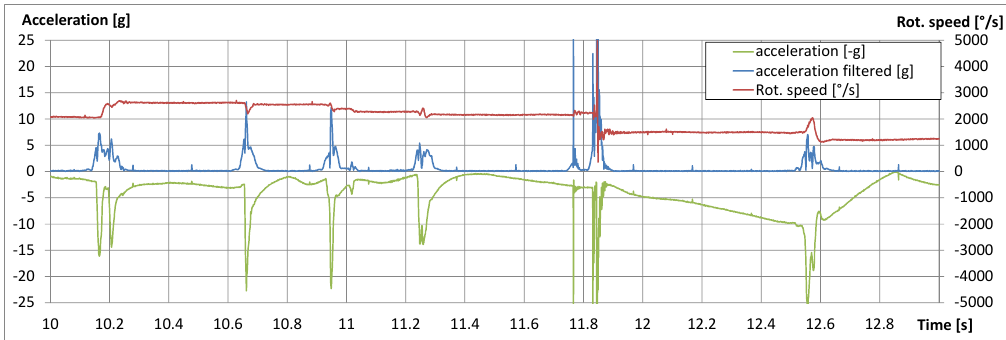
Figure 14. Example (Test 7) for the effect of a Butterworth Filter on the measured accelerations (accelerations in three dimensions were combined using Pythagoras’ theorem). In addition the rotational velocity has been plotted to visualize its relation to impacts.